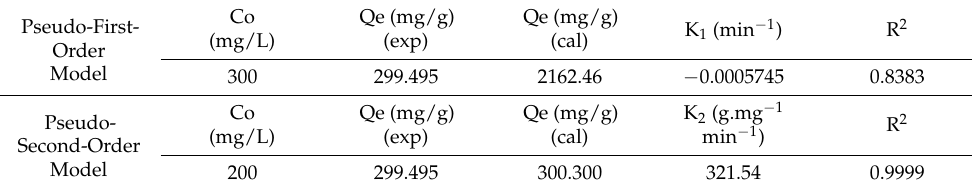
Table 2. Parameters of pseudo-first- and pseudo-second-order .